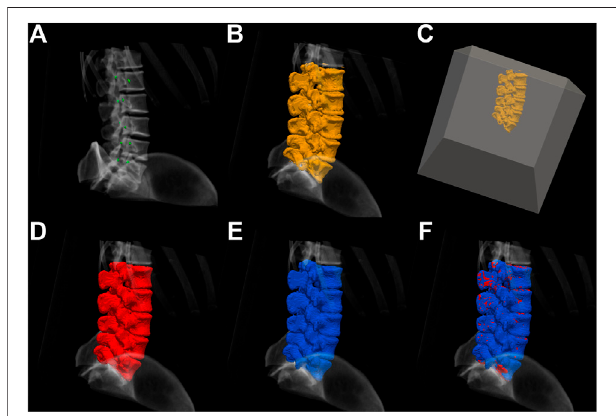
FIGURE 3 | (A) The initialization by placing seeds, (B) the extracted surface using the region-based fl ow on the fl ux-map, and (C) an automatically-placed bounding-box placed around the extracted surface, which starts the process of shrink-wrapping around the middle segmentation, thus closing small holes in the surface. (D) The resulting spine segmentation, which now contains a vertebral volume, (E) a ground truth segmentation image obtained by manual segmentation, and (F) the obtained segmentation overlaid on the ground truth. The process is detailed in Section 2.3.1